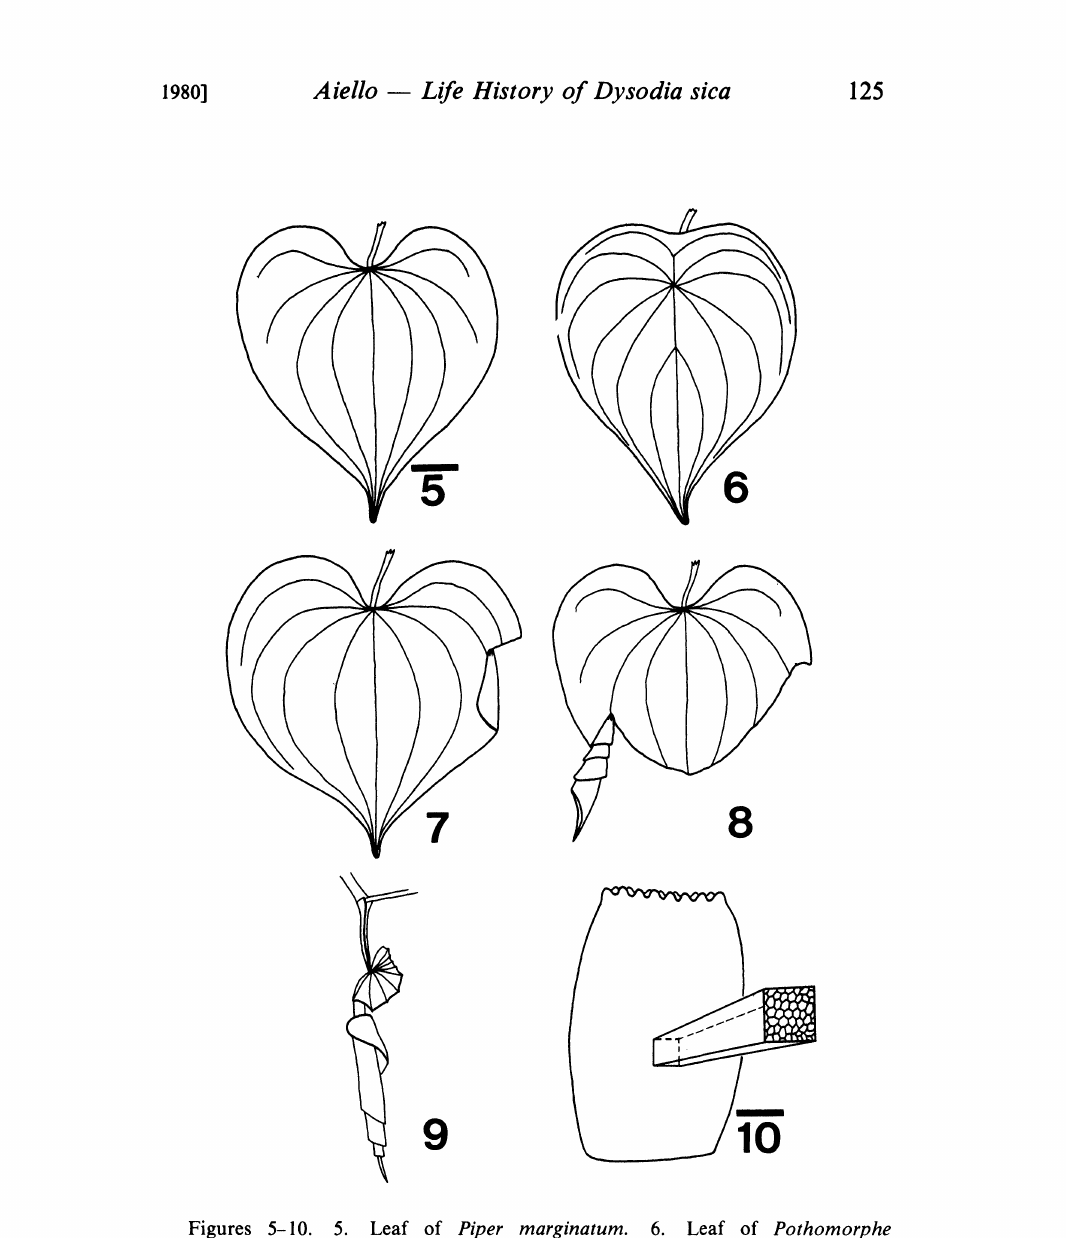
Figures 5-10. 5. Leaf of Piper marginatum. 6. Leaf of Pothomorphe peltata. 7. Leaf roll made by first instar Dysodia sica. 8. Leaf roll made by fourth instar larva. 9. Leaf roll made by final instar larva. Scale 23 mm. 10. Egg, showing portion of recticulate sculpturing. Scale 0.25